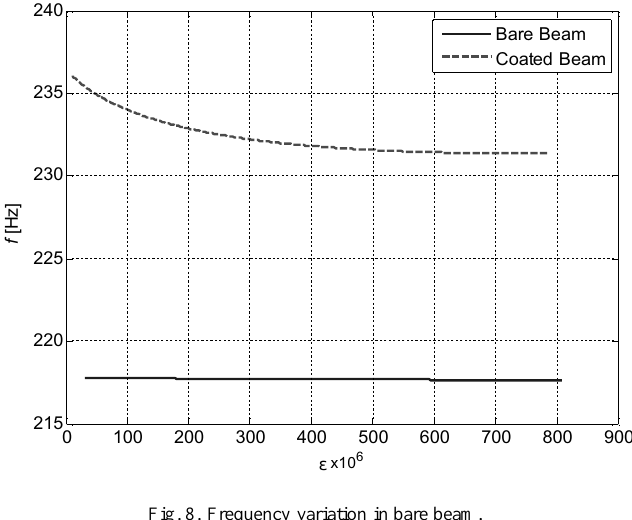
Fig. 8. Frequency variation in bare